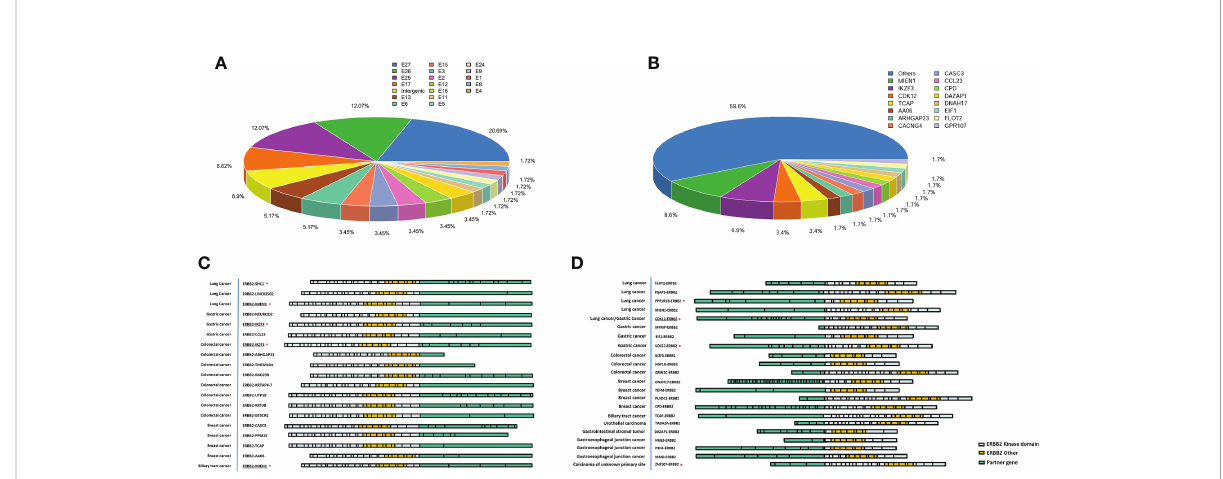
FIGURE 3 ERBB2-KD rearrangements in solid tumors. (A) Frequency of fusion between different exons of ERBB2 . (B) Frequency of ERBB2-KD fusion variants ’ partners. Schematic of all ERBB2-X fusions (C) and X-ERBB2 fusions (D) identi fi ed, at scale with exons represented by individual boxes. The partners is colored pink, with ERBB2 kinase domain colored orange and other ERBB2 exons colored white. The reported ERBB2 fusions marked with the red asterisk, others were novel ERBB2 fusions. The underlined marks are the same fusion gene with different break point